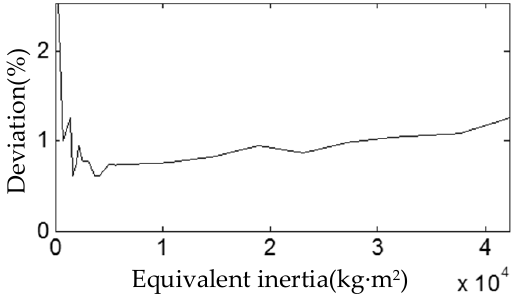
Figure 24. Simulated deviation of electrical inertia.